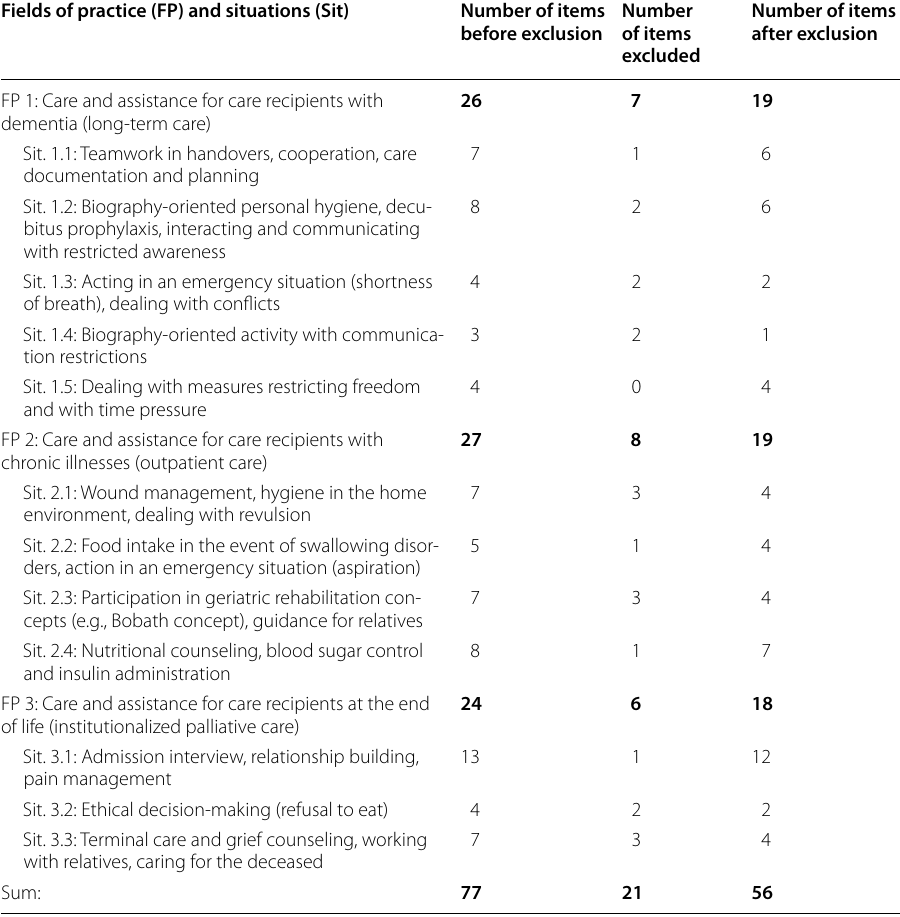
Table 4 Item distributions across fields of practice and situations before and after exclusion Fields of practice (FP) and situations (Sit) Number of items